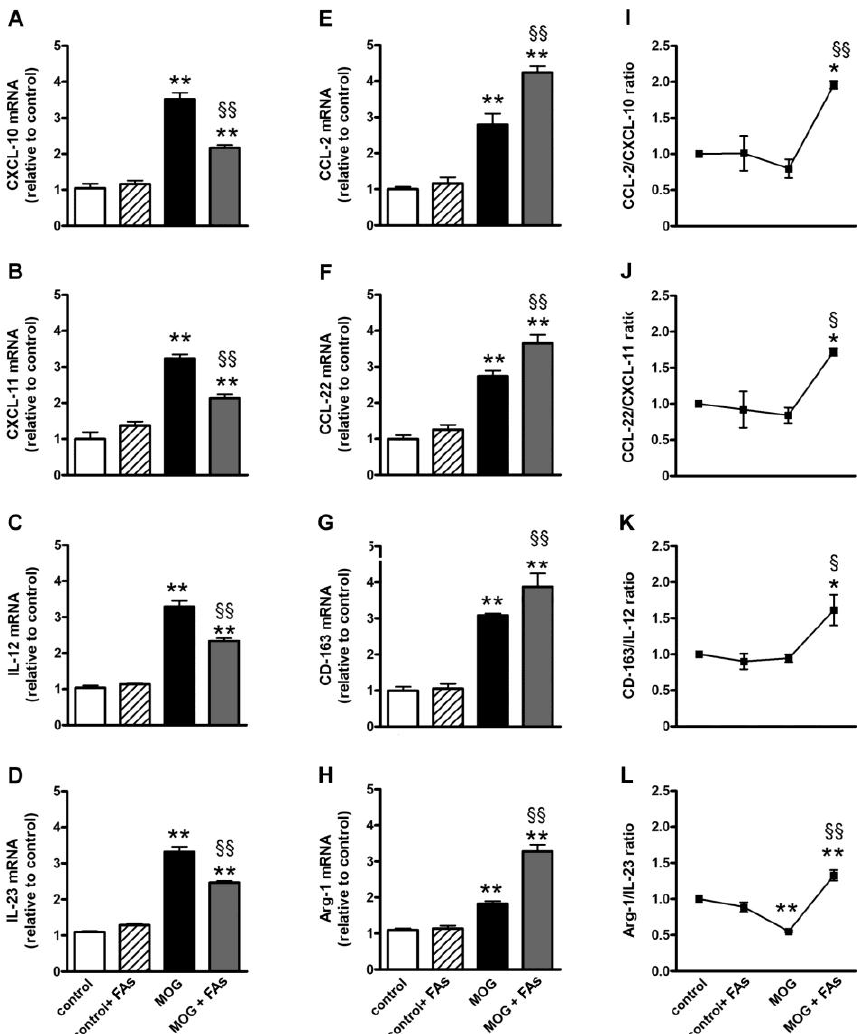
Figure 1. Dietary supplementation with fatty acids (FAs) reduces upregulated levels of M1-related markers including C-X-C motif chemokine (CXCL)-10 (in A ), CXCL-11 (in B ), interleukin (IL)-12 (in C ), and IL-23 (in D ), while additionally increases upregulated levels of M2-related markers including C-C motif chemokine (CCL)-2 (in E ), CCL-22 (in F ), cluster of differentiation-163 (CD-163, in G ), and arginase-1 (Arg-1, in H ). Transcript levels were evaluated in retinal homogenates from control and oligodendrocyte glycoprotein (MOG)-treated mice, without or with FAs supplementation by relative quantification with quantitative real-time PCR (qPCR). Data were analyzed by the formula 2 − ∆∆ CT using ribosomal protein L13A (Rpl13a) as the internal standard. Ratio of the mean values of CCL-2 to CXCL-10 ( I ); CCL-22 to CXCL-11 ( J ); CD-163 to IL-12 ( K ); and Arg-1 to IL-23 ( L ). Data are shown as the mean ± S.E.M. ( n = 9 for each experimental group). * p < 0.01; ** p < 0.001 versus control. § p < 0.01; §§ p < 0.001 versus MOG (One way ANOVA followed by the Newman–Keuls multiple comparison post-hoc test). White bars, control mice; dashed bars, control mice with FAs supplementation; black bars, MOG-treated mice; grey bars, MOG-treated mice with FAs